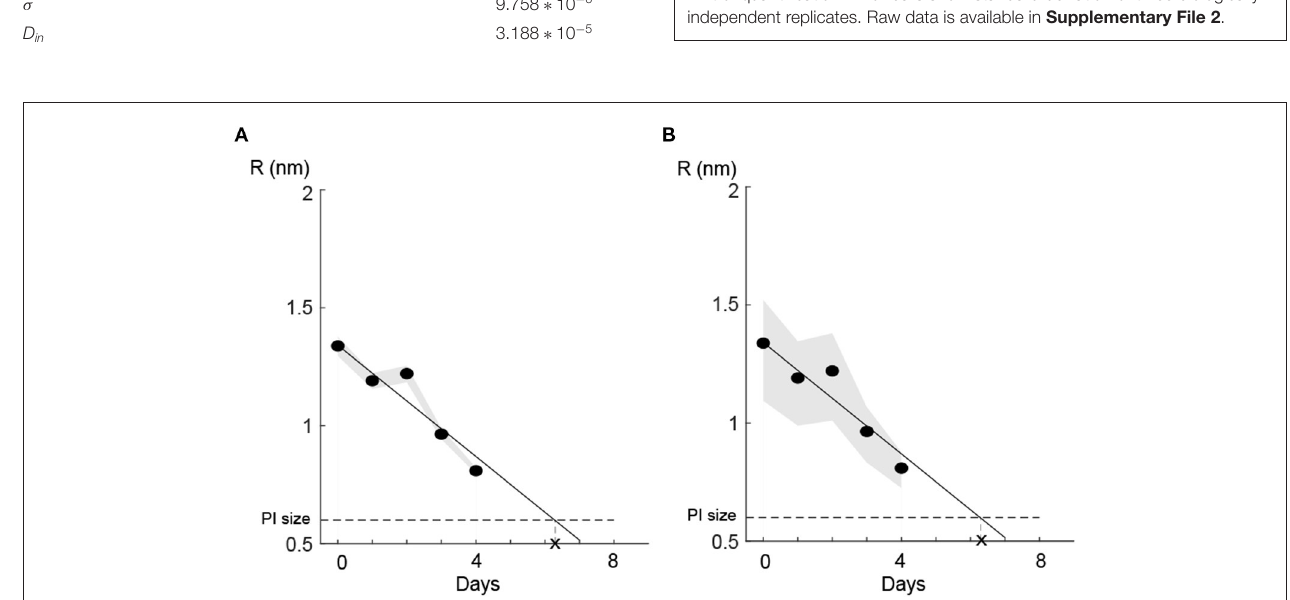
Frontiers in Microbiology |